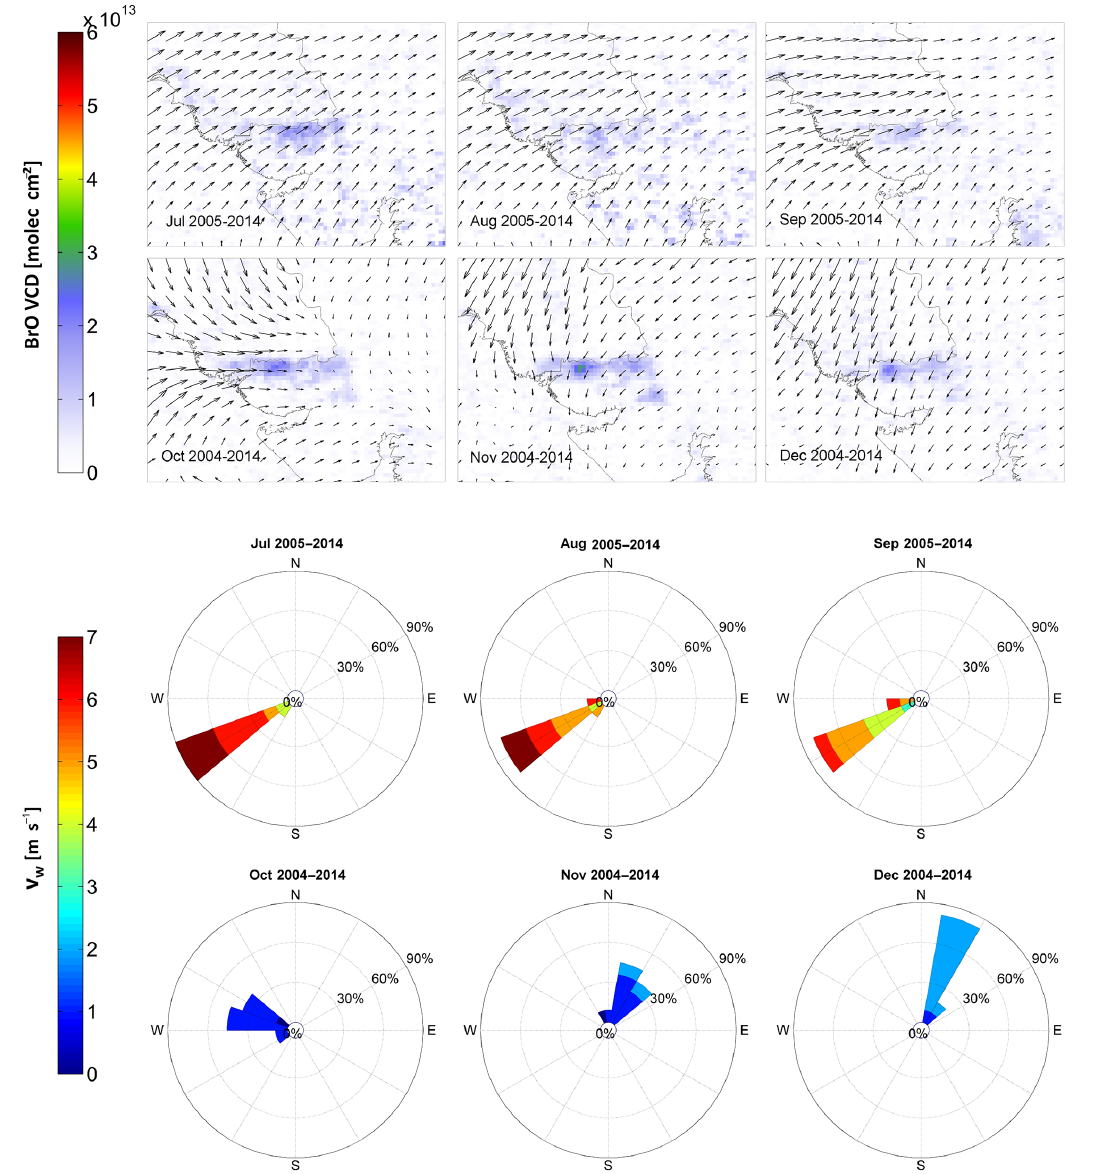
Figure 8. Same as in Fig. 7, but for July to December 2004–2014. The area is mainly affected by strong southwestern winds during monsoon months ( > 7ms − 1 ). After the monsoon, the wind speed drops rapidly ( ≈ 2ms − 1 ), and the wind direction changes from west (October) to northeast during